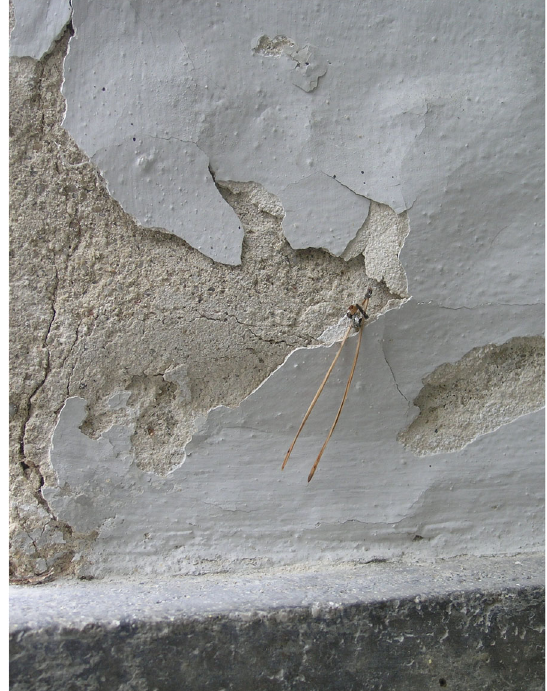
Fig. 14 Dessau, master house Klee / Kandinsky, 1926; the original material-coloured smoothed plaster appears under the recent titanium-white coating, possibly containing a synthetic resin component, in 2006 (Source: Ivo Hammer)